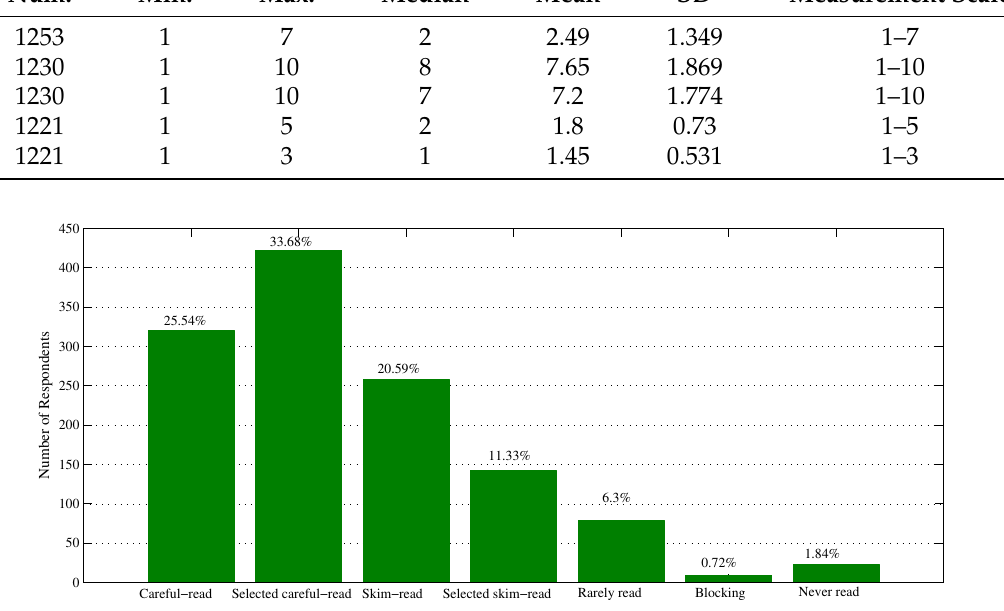
Figure 1. Reading situation.